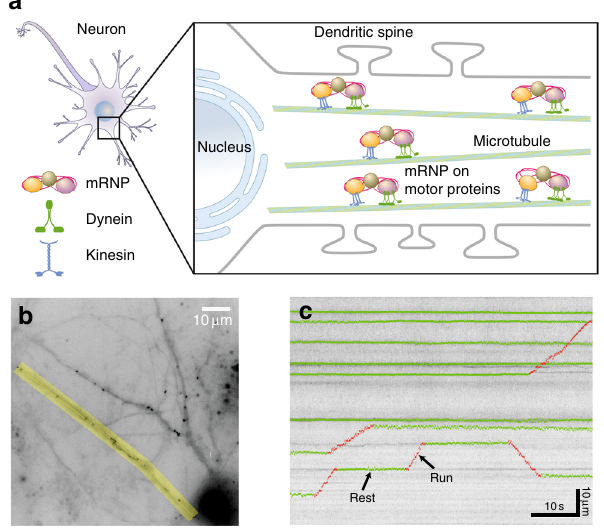
Fig. 1 Schematic and experimental data showing motor-driven transport of mRNPs in a neuron. a An ensemble of mRNP complexes are transported by kinesin and dynein motor proteins along microtubules in the dendrite. In each dendrite, there are multiple microtubule tracks and thus several mRNP particles are ef fi ciently transported at the same time to the target sites where they are localized. b A live-cell image showing fl uorescently labeled β -actin mRNP complexes in a hippocampal neuron. Time-lapse images were taken with a time interval of t 0 = 0.1 s for the overall observation time of T = 60 s. The region of interest for analysis is marked in yellow. Scale bar, 10 μ m. c A kymograph for an ensemble of mRNP particles obtained from an image similar to the yellow area in ( b ). Horizontal and vertical axes correspond to the elapsed time and the distance along the dendrite, respectively. For a few trajectories, their two distinct dynamic modes, rest and run, are denoted in green and red, respectively. The kymographs exhibit constant small-length scale fl uctuations (see Supplementary Fig. 1 for more information). Scale bars, 10 s and 10 μ m,